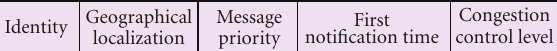
Figure 5: Structure of a